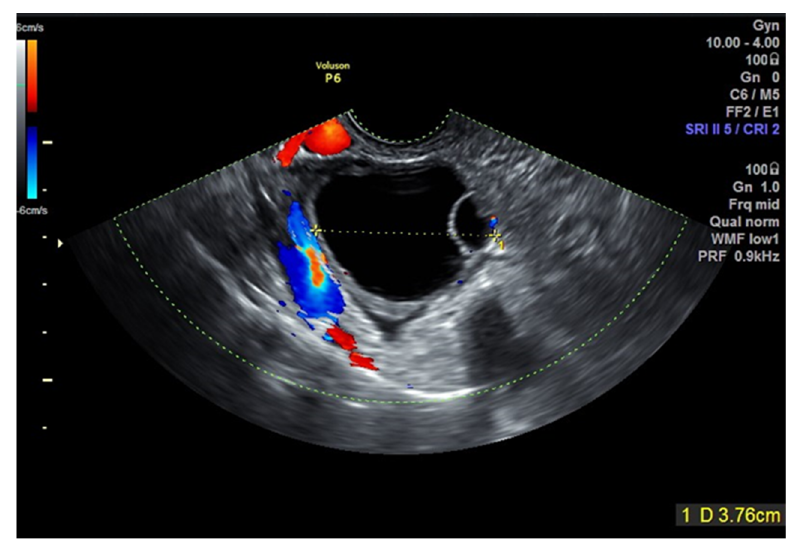
Figure 4. Case number 7; 36 years old woman, presented without symptoms. On TVUS multilocular cyst, hystological result was a serous cystadenoma.